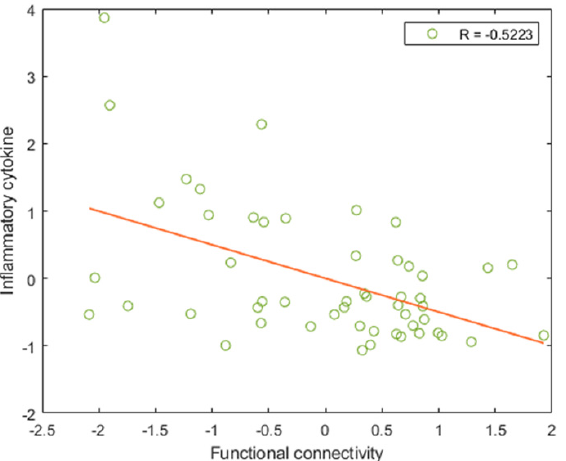
Figure 4. Correlation between inflammatory cytokines and the features of prediction models. The relationship of the C-reactive protein with the functional connectivity between the left postcentral cortex within the motor network and the left superior parietal cortex within the visual association network is also indicated. This connectivity was a minor feature for predicting the changes in the YMRS score. The correlation analyses were conducted by controlling the body mass index and correcting the false discovery rate. The orange line represents the best fit for the data points.